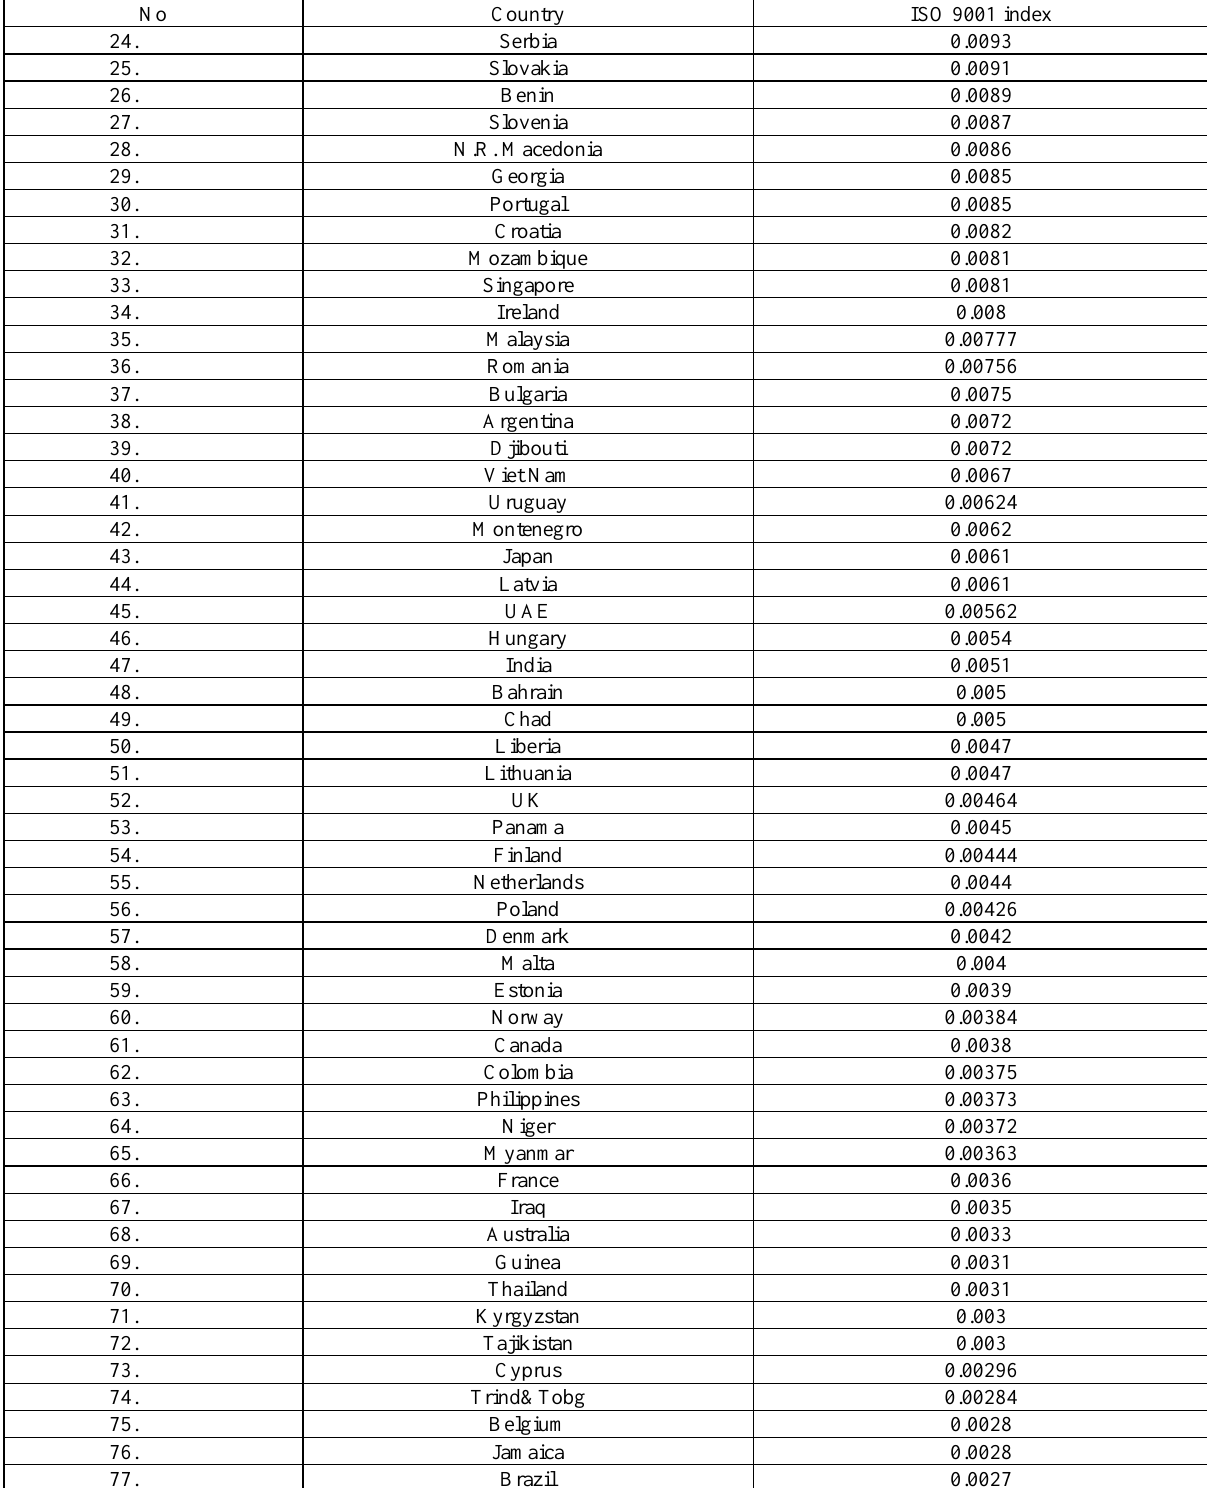
Table 3 (cont.). List of countries for ISO 9001 index based on the number of ISO 9001 certificates issued divided by the number of businesses per each country (136 countries worldwide, drawn from the author of